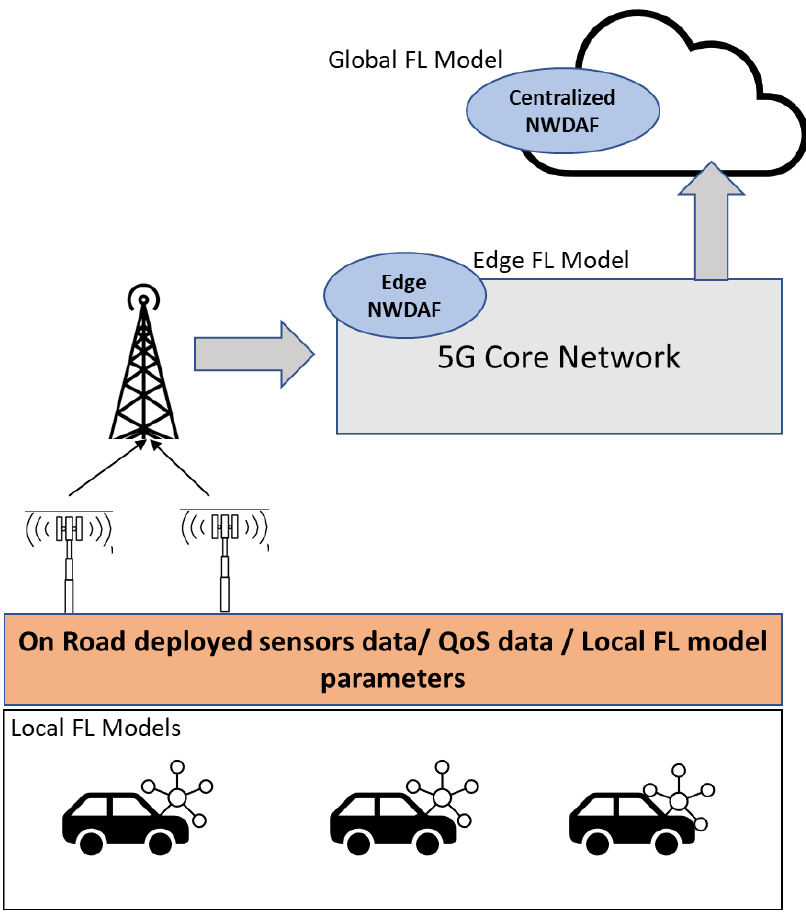
Figure 5. High-level design of our NWDAF